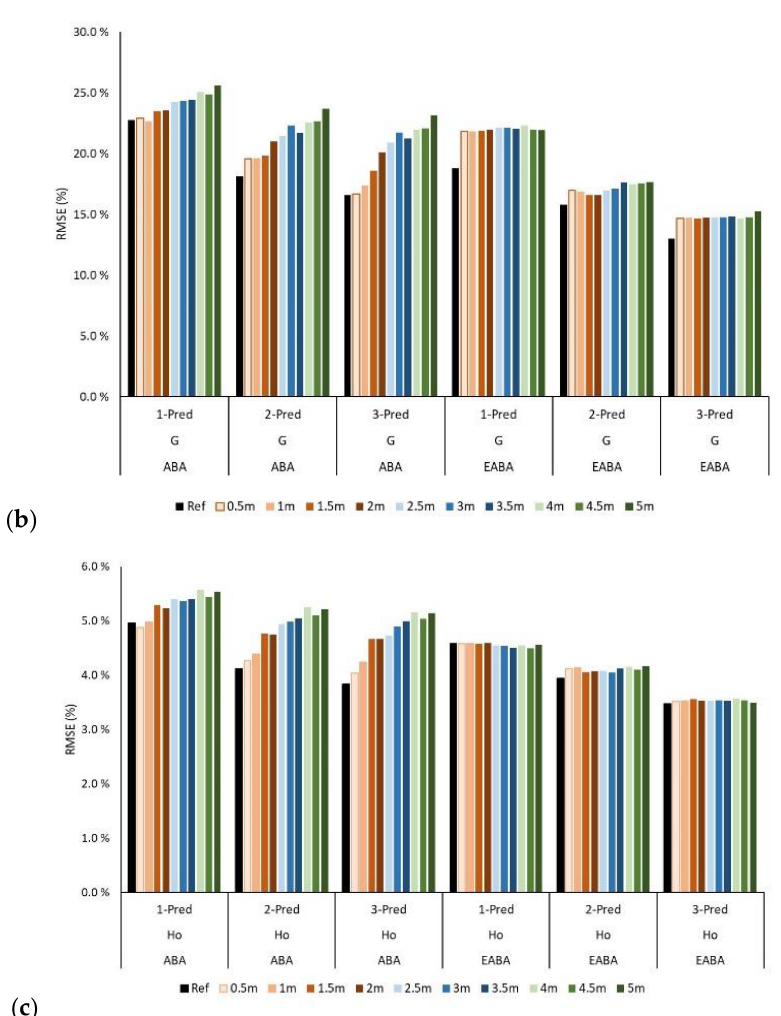
Figure 6. Computed RMSE (expressed as the percentage value over the mean value of the ground measurements) of the selected one-, two-, and three-predictor models using ALS datasets containing co-registration errors ranging from 0.5 to 5 m. The results are presented for ( a ) growing stock volume ( V ); ( b ) stand basal area ( G ); ( c ) dominant height ( H o ).